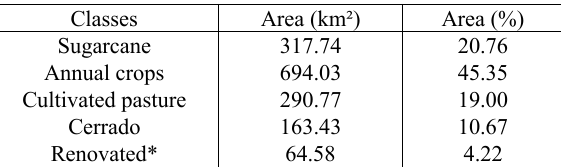
Table 2 . Detailed information about the Harmonized Landsat 8 Sentinel-2 (HLS) data used in this study.